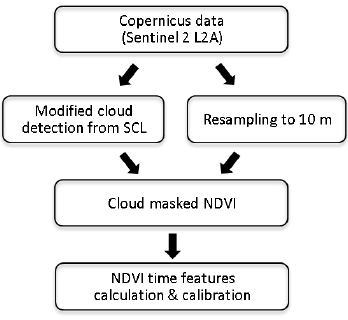
Figure 1 . Simplified Sentinel-2 Pre-Processing for